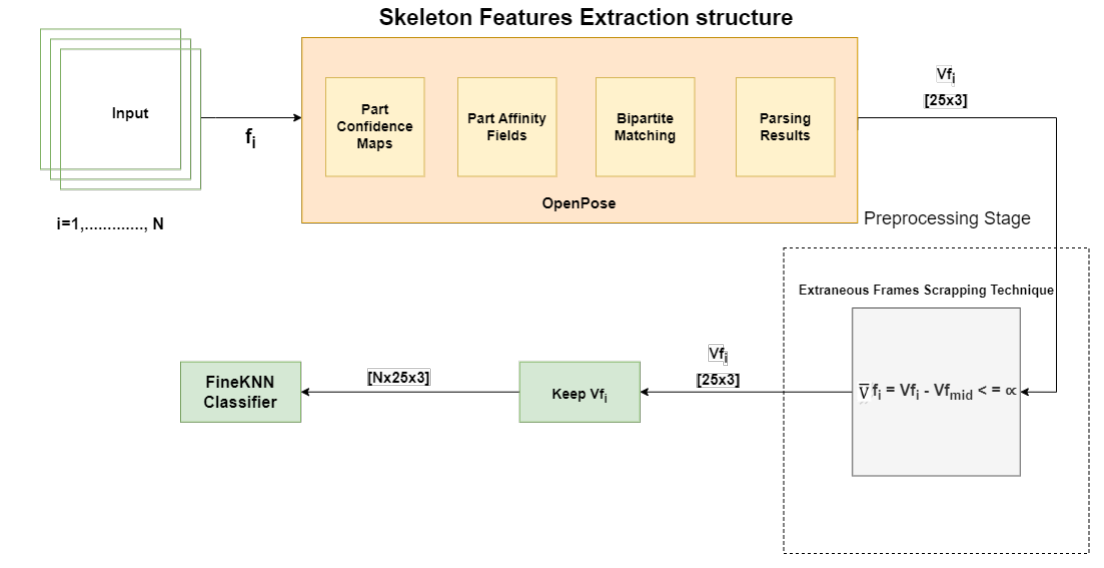
Figure 3. Proposed Methodology for HAR system based on skeleton data using EFS